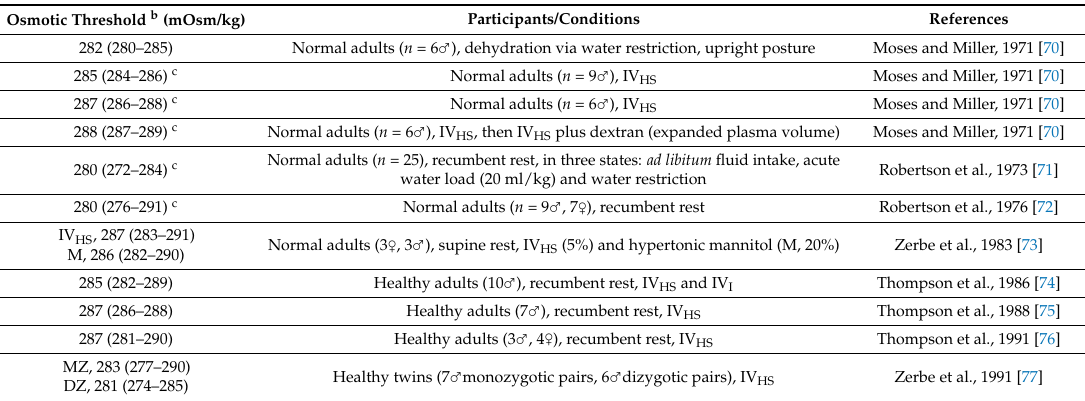
Figure 2. Frequency distribution of the habitual total water intake (TWI, 5-d mean values, n = 120) of healthy, college-aged women ( n = 120). Reprinted with permission (Johnson et al., 2016 [13]). Table 4. Plasma osmotic threshold a for plasma AVP